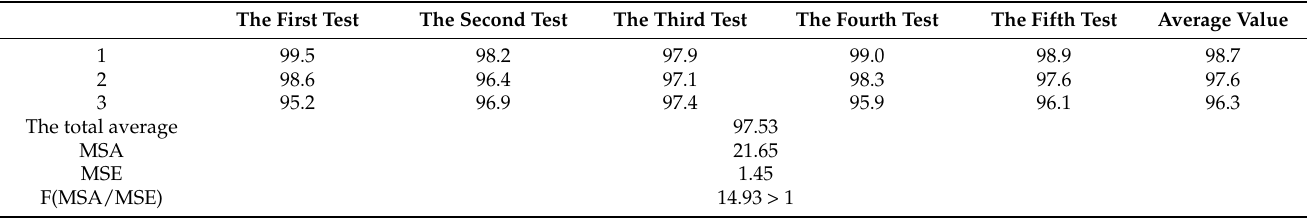
Table 4. Strong retention analysis of